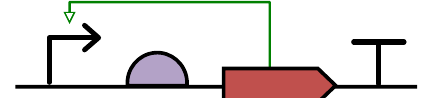
Figure 38: Promoter stimulated by the CDS that it regulates.